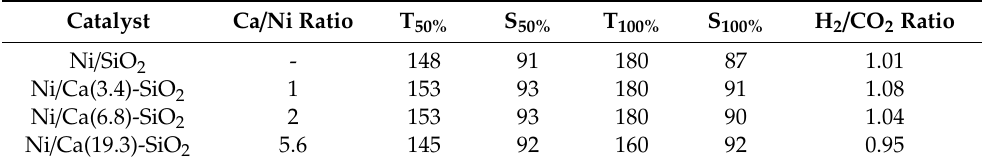
Table 1. Catalytic activity of Ni solids: temperature reaction and H 2 selectivity for 50% and 100%